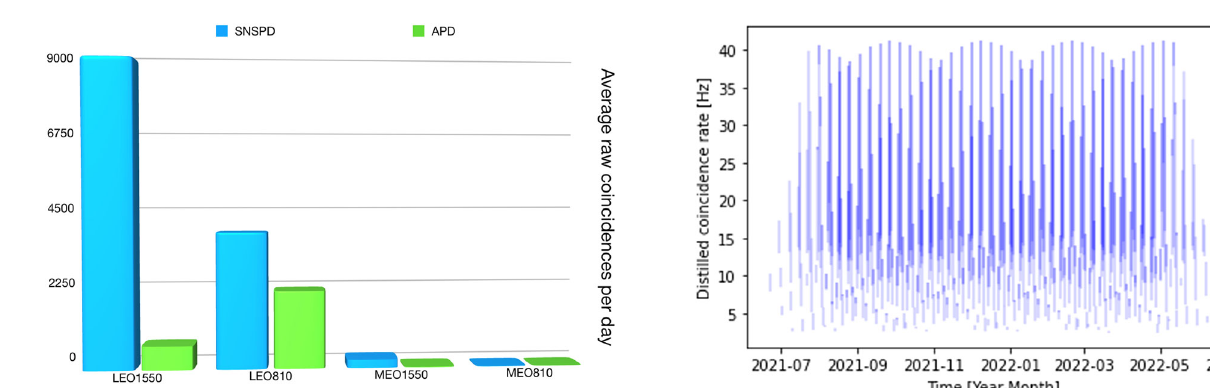
Fig. 9 Distilled coincidence rate for the Sun synchronous orbit at 600 km with inclination of 97.8 degrees. The wavelength of 810 nm allows only night-time operation. The quantum ground stations are assumed to be equipped with super-conducting nanowire single photon detectors. Simulation from July 1, 2021 to July 1, 2022 (meteorological effects not